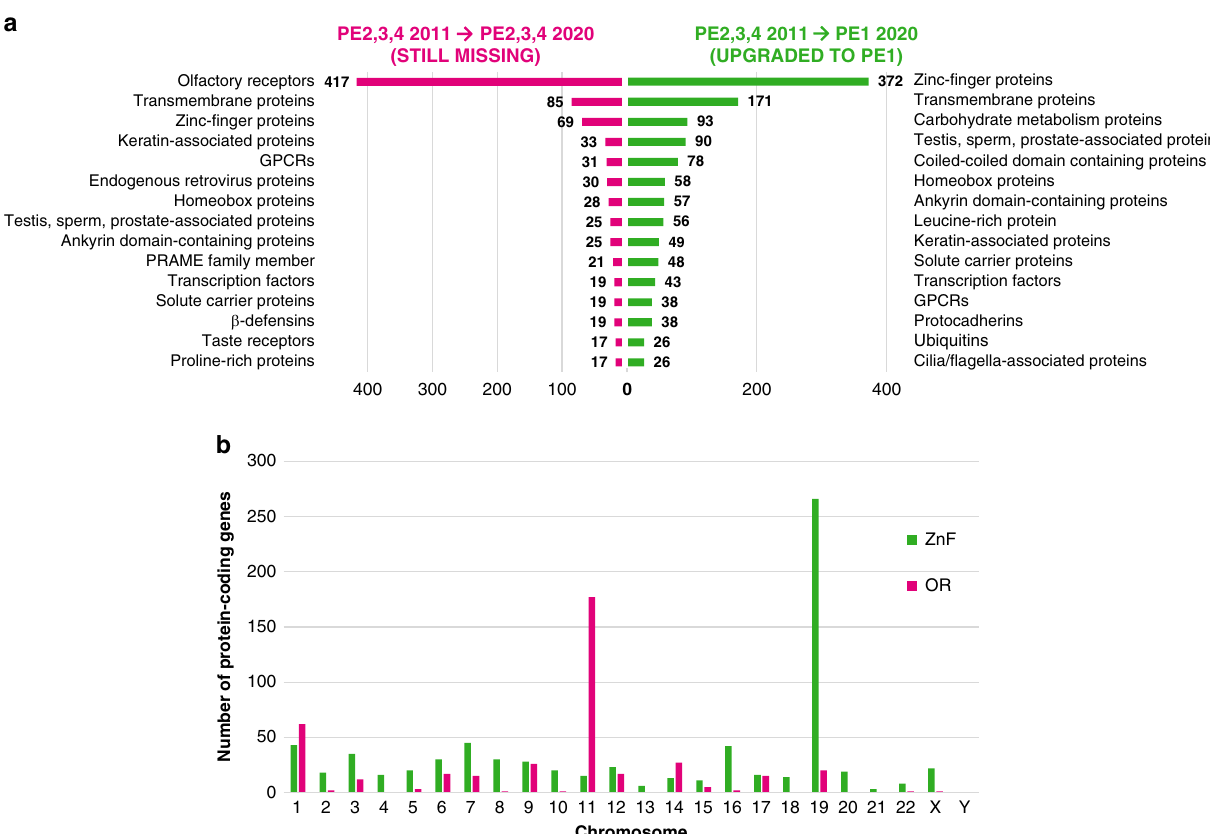
Fig. 3 HPP decadal impact. a The top 15 neXtProt protein descriptor groups/families with the highest number of 2020 PE2,3,4 missing protein members (i.e., lacking high-stringency PE1 evidence of protein existence data; magenta, left) and the top 15 protein descriptor groups that have been upgraded to PE1 since 2011 (green, right). The data illustrates that the OR family has the highest number of 2020 missing PE2,3,4 proteins (magenta bars) and the Zn fi nger protein family has the highest number of discovered PE2,3,4 entries upgraded to PE1 since 2011 b Human chromosomal distribution of the OR and Zn fi nger families neXtProt protein descriptor groups/families. This example data clearly illustrates that the positioning of multiple ORs (magenta vertical bars) or Zn fi nger protein-coding genes (green vertical bars) on certain chromsomes explains why Chr 11 appears more resistant and Chr 19 more susceptible to PE1 discovery over the